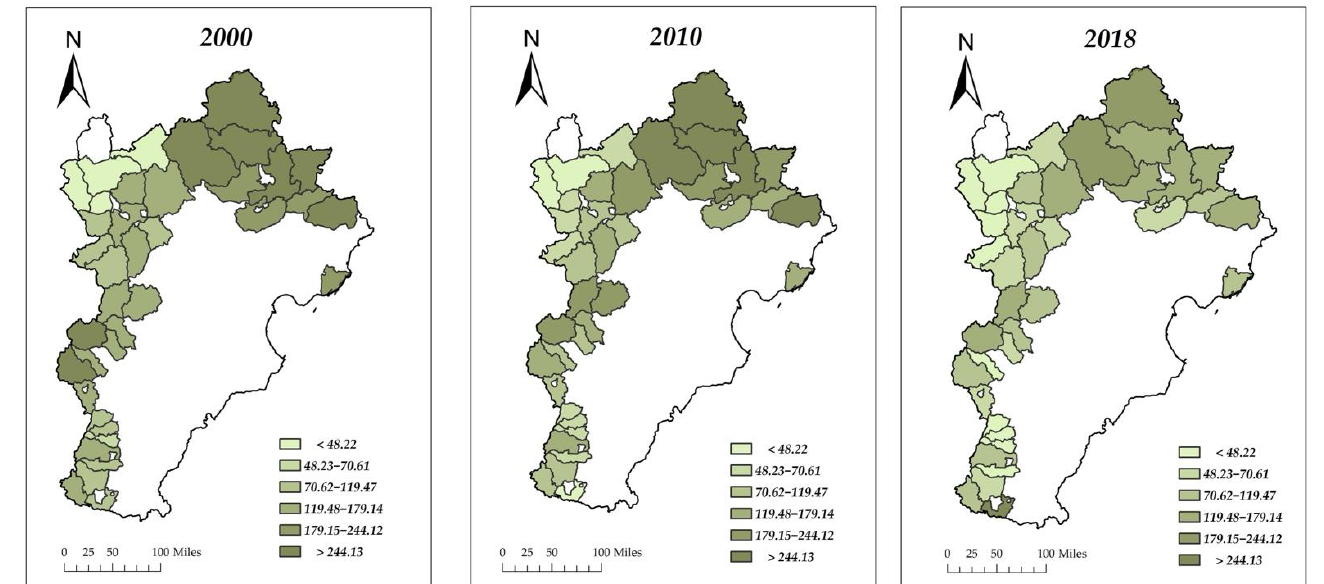
Figure 3. Changes in forest fragmentation in the Beijing–Tianjin–Hebei region, 2000, 2010, and 2018.